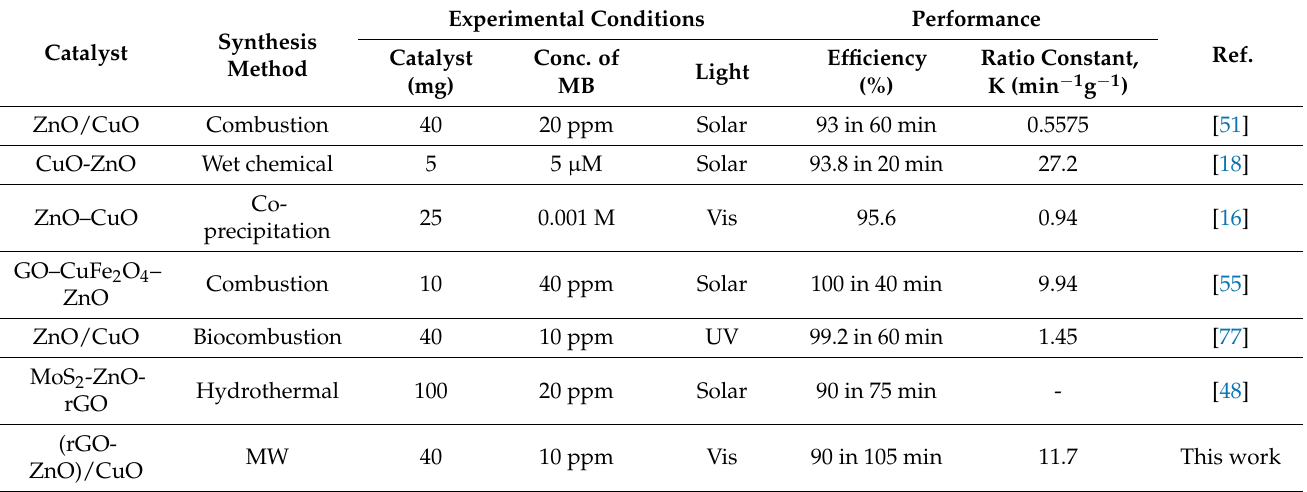
Table 1. Comparison of (rGO-ZnO)/CuO NCs to previous reports against photocatalytic degradation of